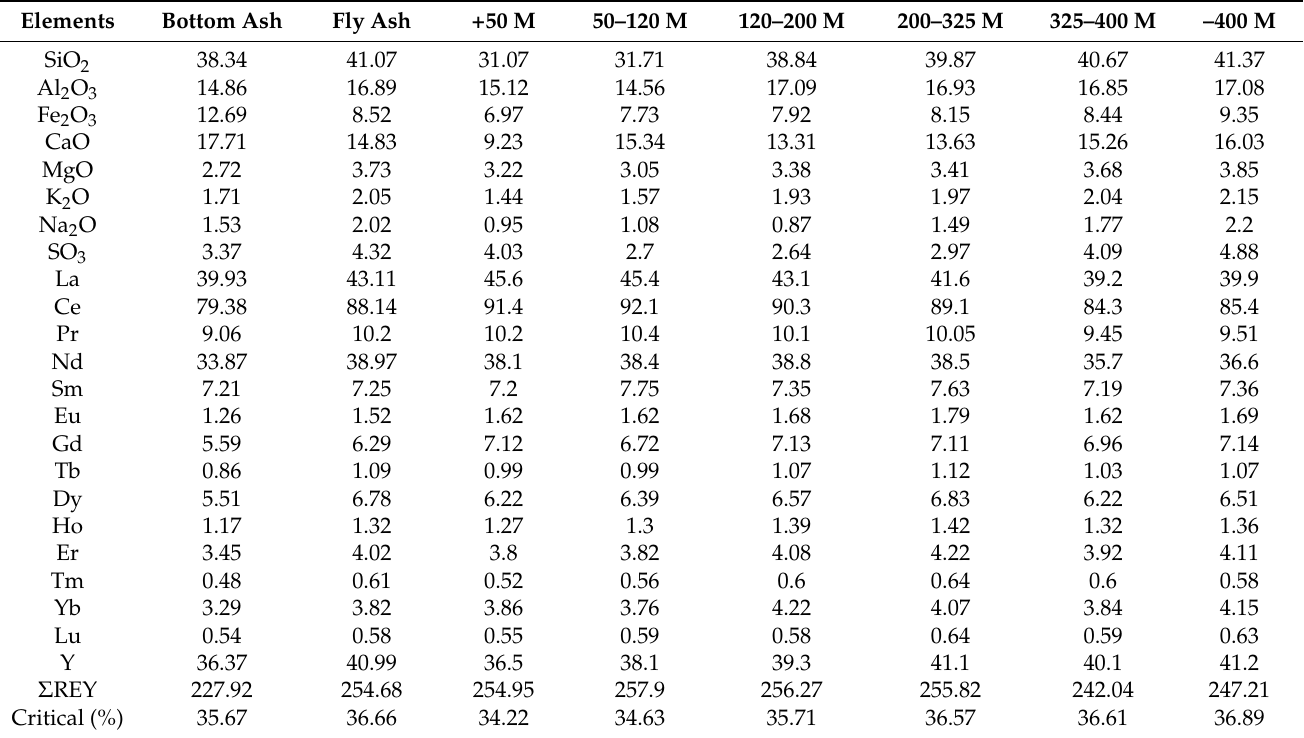
Table 1. Chemical composition of the initial samples and of the various size